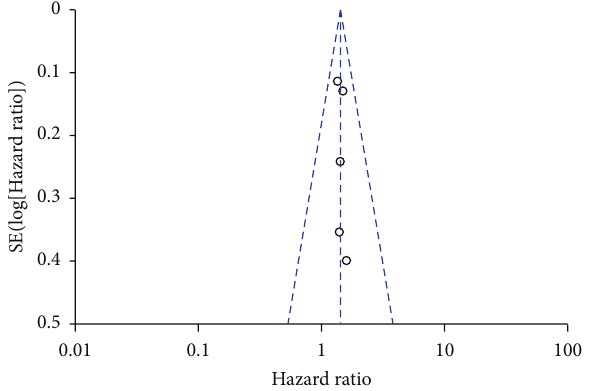
Figure 3: The funnel plot of current versus never